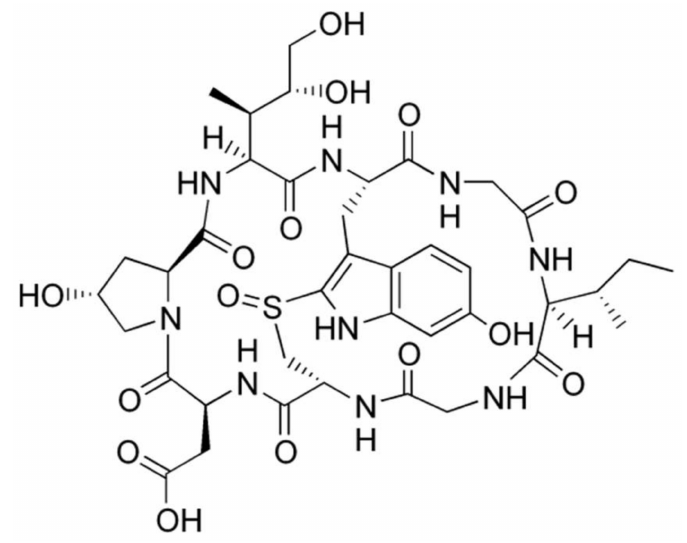
Figure 1. The chemical structure of β